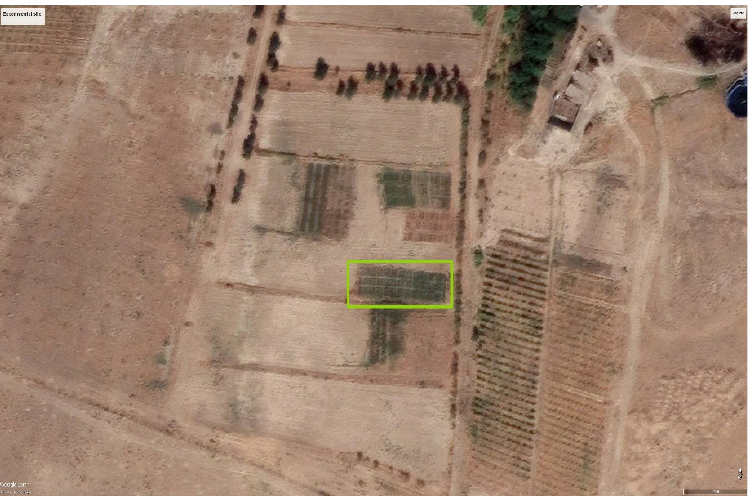
Table 5. Prior to any field activity, the soil physico-chemical properties of the experimental area (at a depth of 0–30 cm) were analyzed and are shown in Table 6.